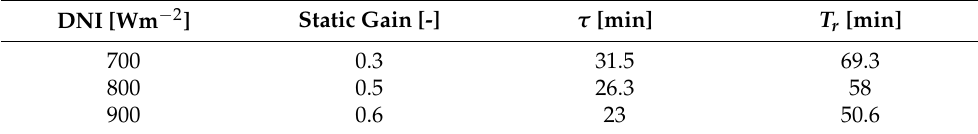
Table 1. First-order dynamic model corresponding to the temperature curves shown in Figure 2.